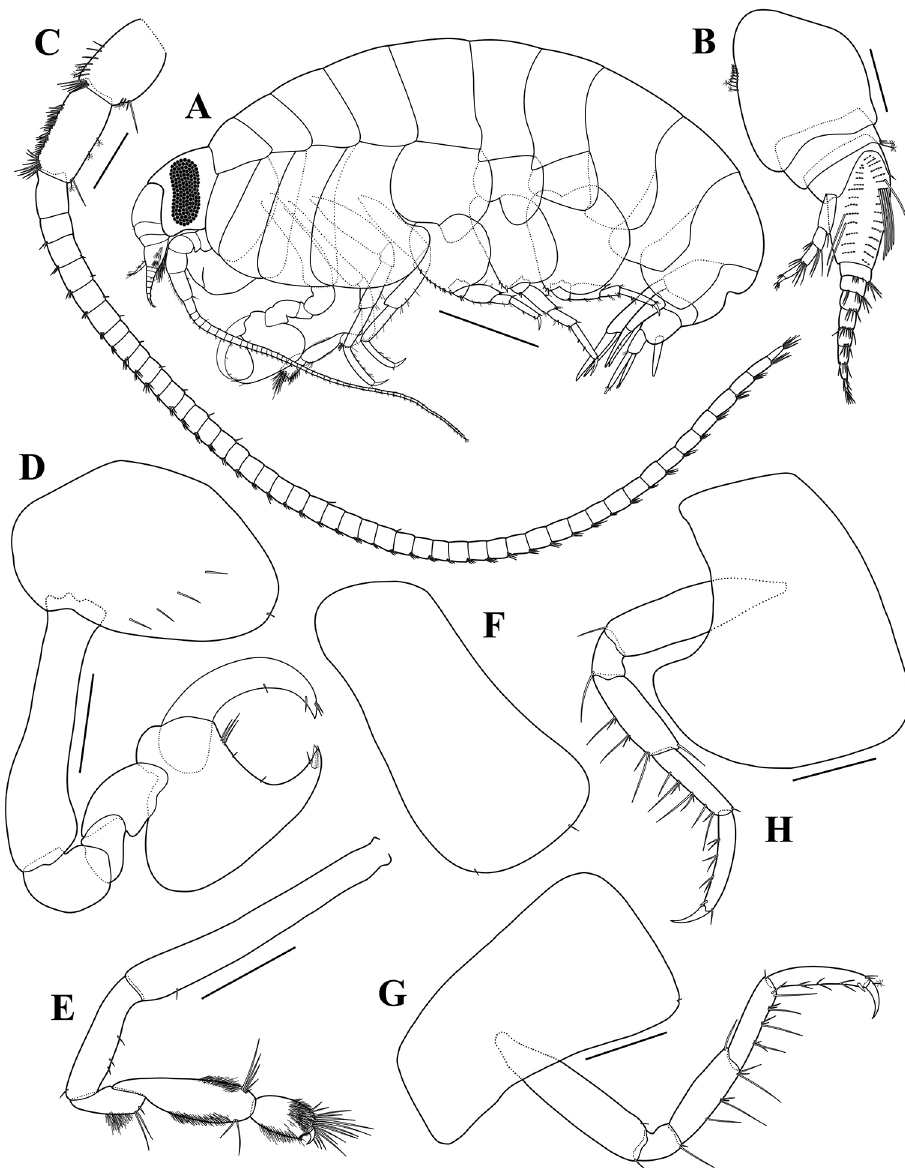
Figure 6. Opisa takafuminakanoi Narahara-Nakano, Kakui & Tomikawa, 2016, adult male, NI- BRIV0000880624, 8.8 mm A habitus B antenna 1 C antenna 2 D gnathopod 1 E gnathopod 2 F coxa 2 G pereopod 3 H pereopod 4. Scale bars: 1.0 mm ( A ), 0.2 mm ( B, C ), 0.4 mm ( D–H ). elongated, slightly shorter than carpus, with 3 anterior and 1 posterodistal setae; merus 0.58× ischium, with patch of setules posteriorly and 3 unequal simple setae posterodis- tally; carpus elongated, 0.49× basis, anterior and posterior margins covered with setules and with distal unequal group of setae, posterior margin slightly convex;